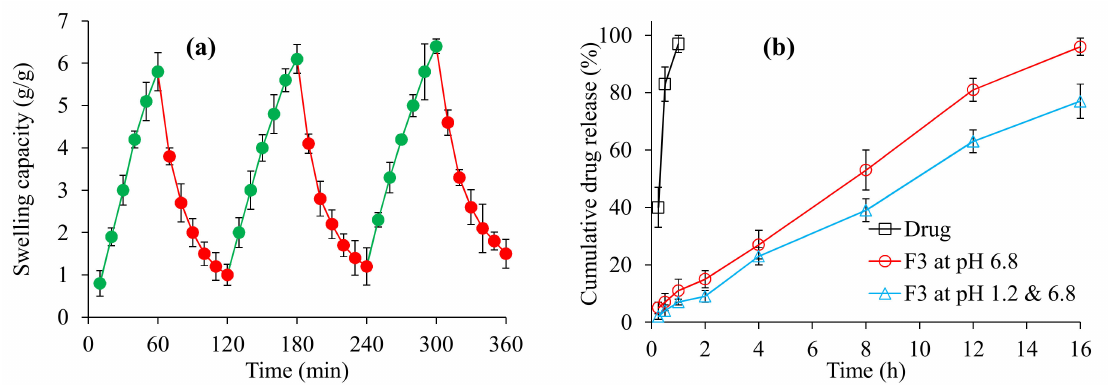
Figure 6. On–off switching (swelling and deswelling) studies of MPM-based oral tablet formulation F3 ( a ) and drug (itopride) release from MPM-based oral tablet formulation F3 at pH 6.8 and pH 1.2 ( b ).